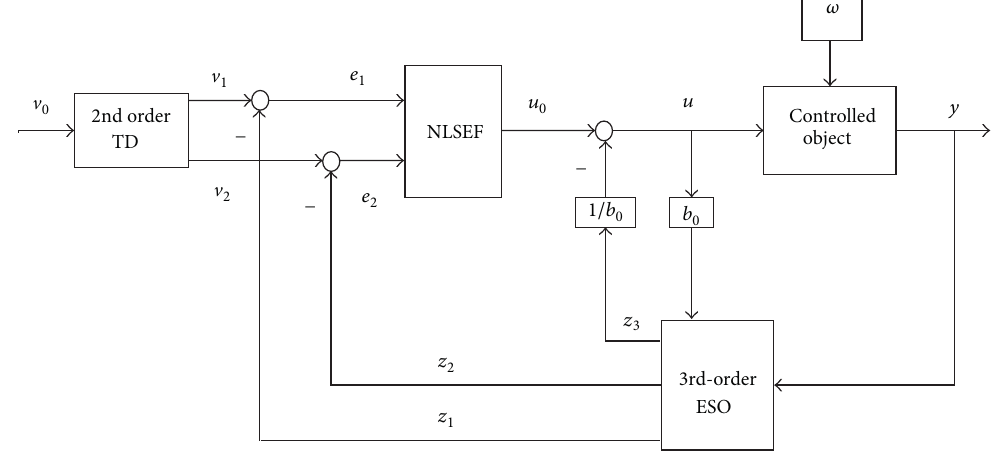
Figure 1: The architecture of